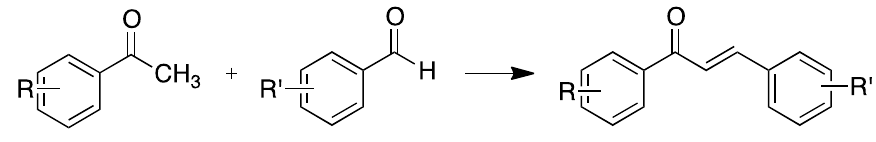
Scheme 1. General scheme for the synthesis of chalcone.